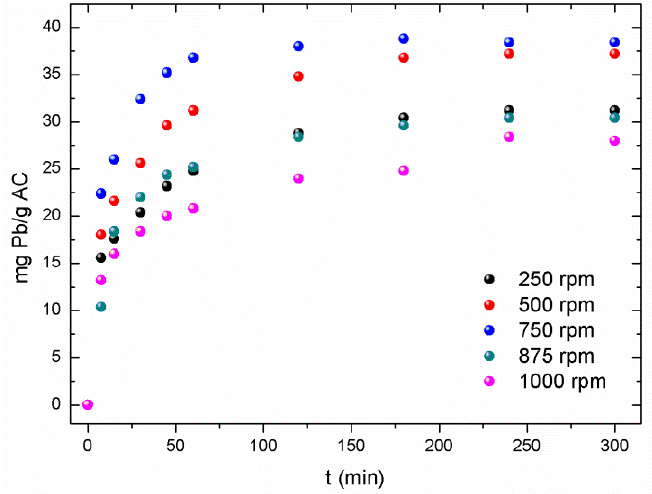
Figure 5. Influence of the stirring rate on Pb 2+ loading.